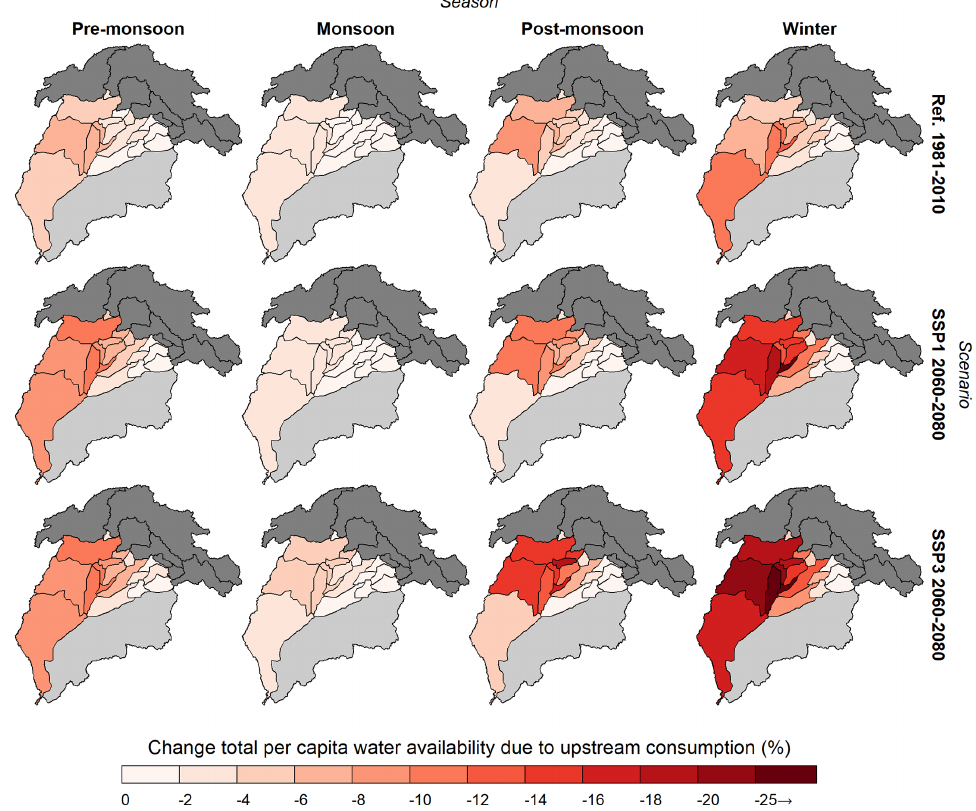
Figure 6. Seasonal mean impact of upper Indus water consumption on the water availability per capita of the lower Indus sub-basins for all years and ensemble members. The dark grey area herein represents the upper Indus sub-basins. The light grey area is not downstream of any of the upper Indus sub-basins and is therefore